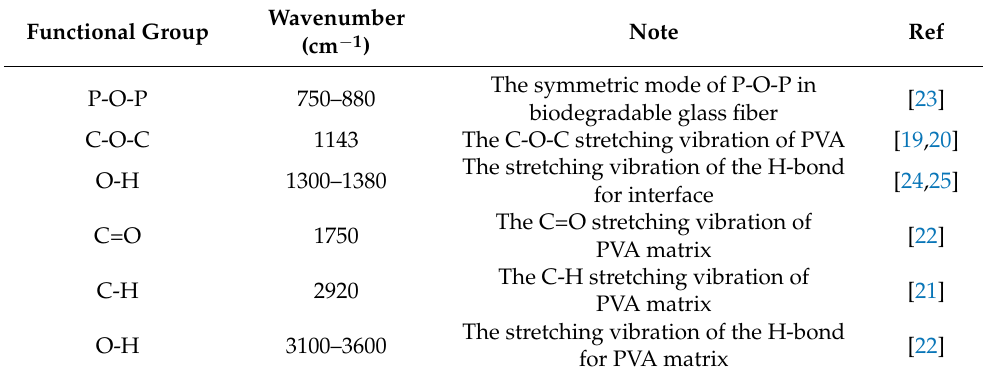
Table 1. The FTIR functional groups and corresponding wavenumber.